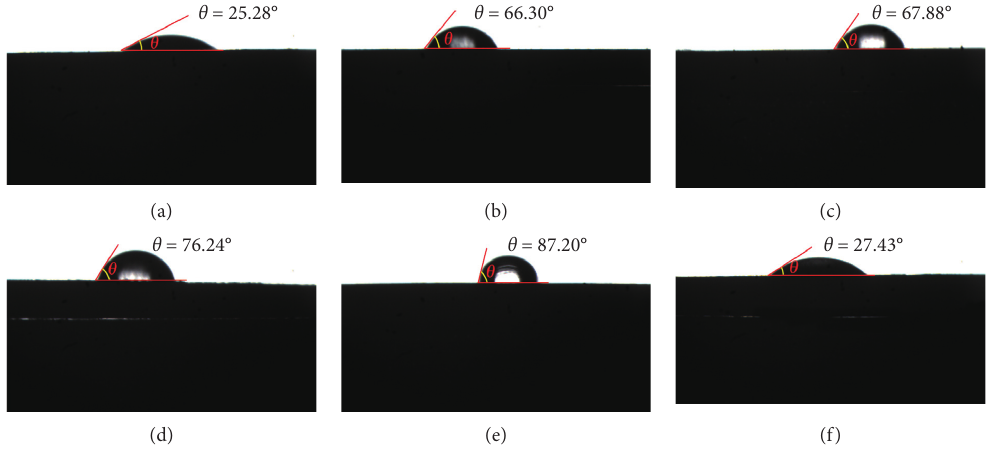
Figure 9: Measured contact angles for different coal samples: (a) lignite, (b) gas coal, (c) fat coal, (d) coking coal, (e) meager-lean coal, and (f)